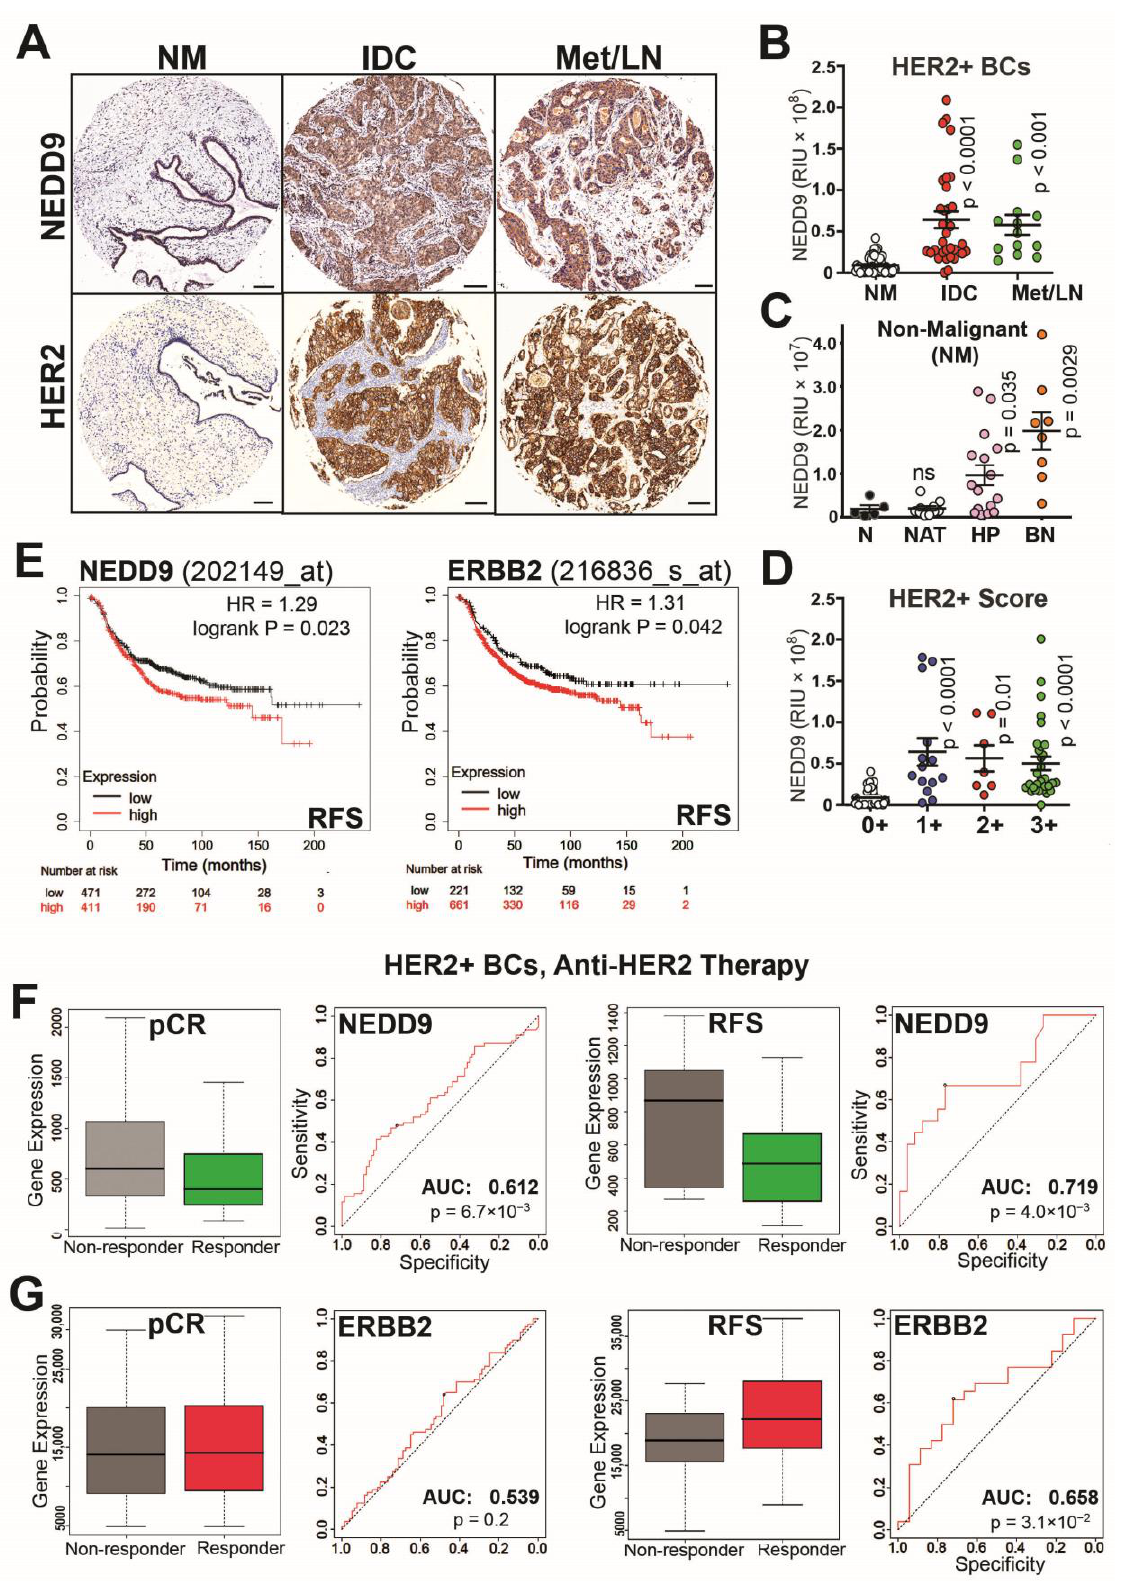
Figure 1. NEDD9 is overexpressed in HER2+ breast cancers and correlates with disease progression, poor survival, and anti-HER2 therapy response. ( A ) Representative images of immunohistochemical staining of tissue microarray (TMA, n = 90, including 40 nonmalignant (NM): 6 normal, 10 normal adjacent to tumor tissue-NAT, 16 hyperplasia, and 8 benign) with anti-NEDD9 and -HER2